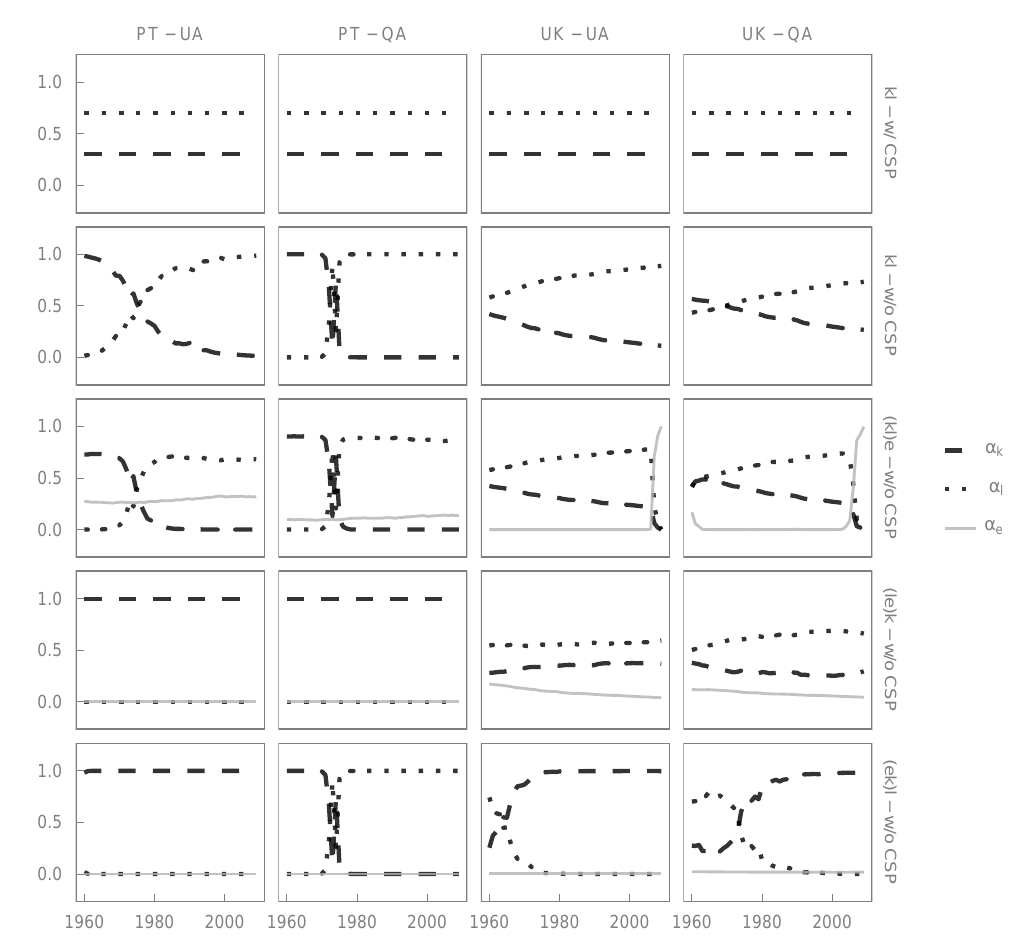
Figure 6. Output elasticities of capital, labor, and energy for Portugal and the United Kingdom (1960–2009). “UA” indicates unadjusted factors of production, and “QA” indicates quality-adjusted factors of production. “w/ CSP” indicates modeling approaches that adhere to the Cost Share Principle. “w/o CSP” indicates modeling approaches that reject the Cost Share